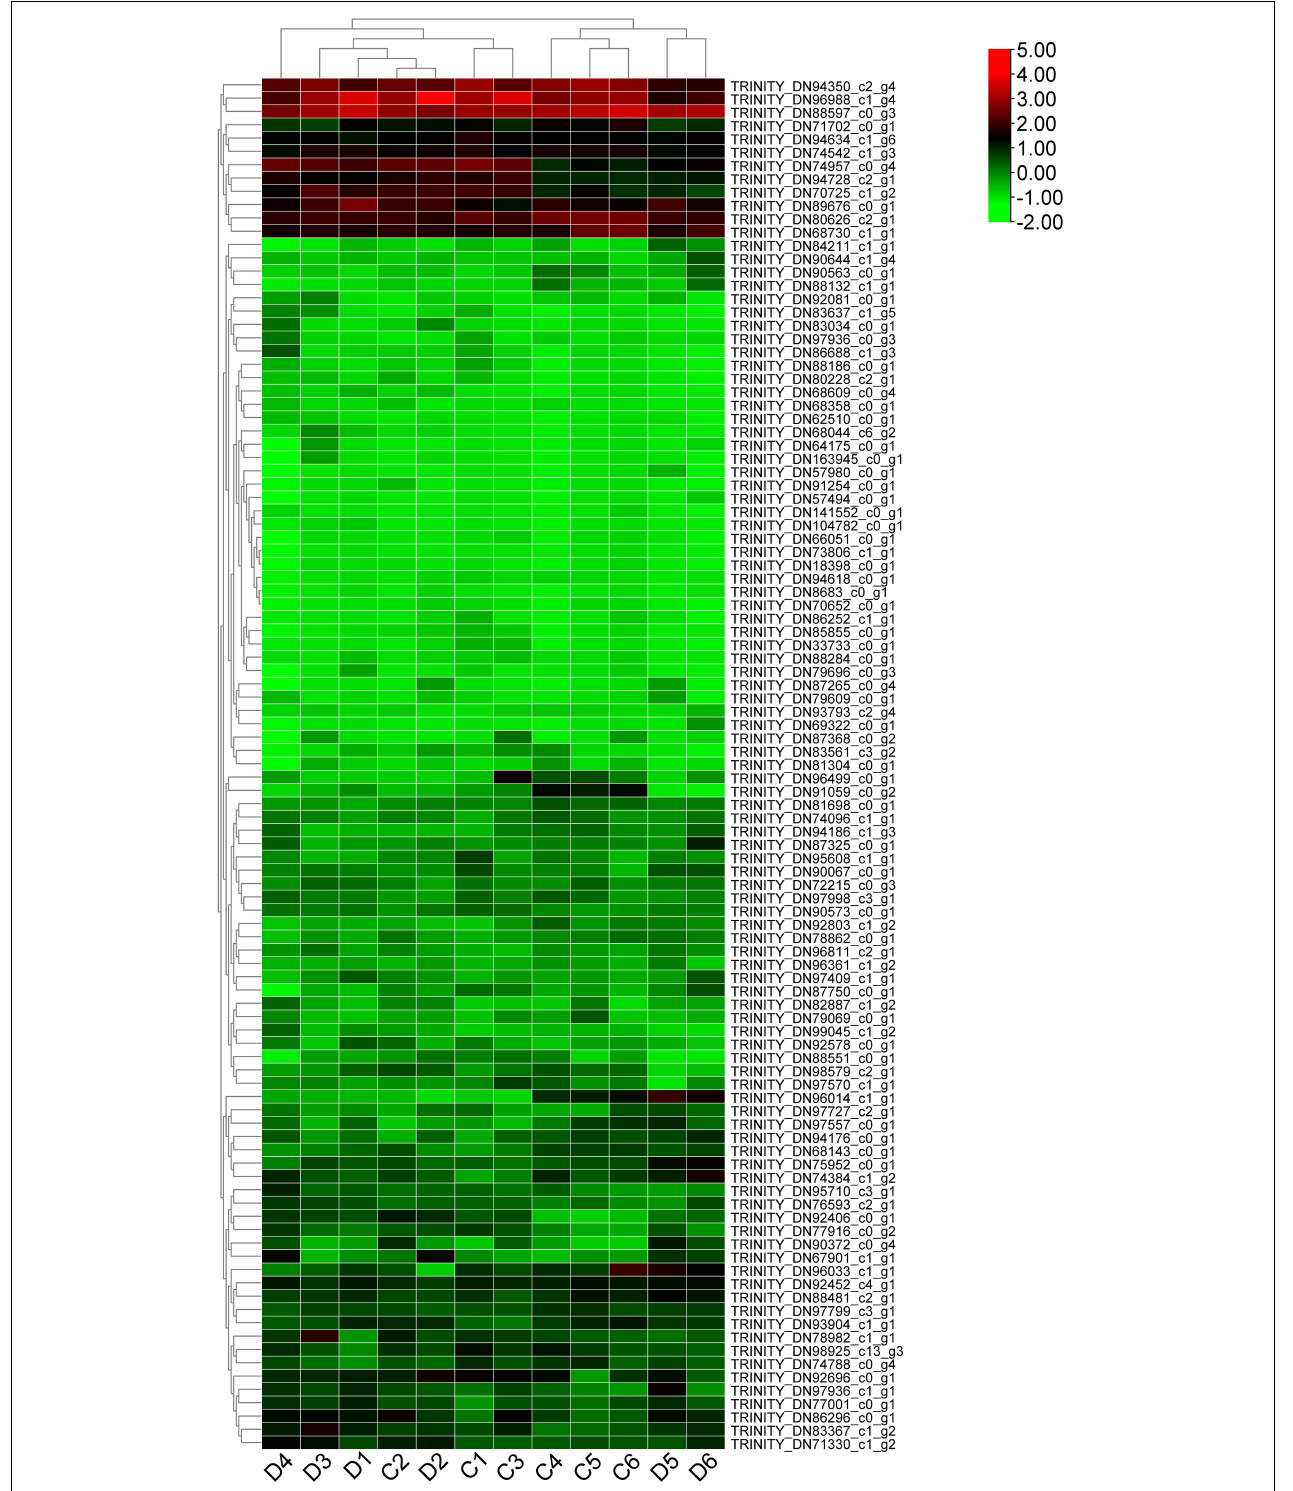
FIGURE 7 | The expression profile of the possible ABC transporter genes in the unbolted and bolted P. praeruptorum . The TPM values are normalized by the log2 function. The expression patterns of PpABC genes can be divided into four groups: the first group has higher levels of expression both at the bolted and unbolted stages. The second group displayed high expressions prior to bolting and low expressions after bolting. The third group is the absolute opposite of the second group. The fourth group had lower expression both at the bolted and unbolted stages.